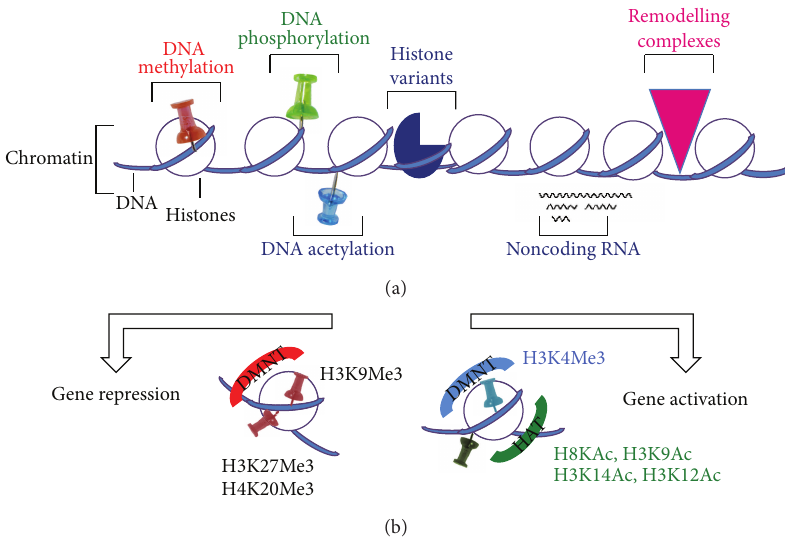
Figure 1: Scheme of histone and epigenetic modifications. (a) Chromatin structure can be modified in 5 different ways: DNA methylation, histone modification, remodeling by chromatin-remodeling complexes, insertion of histone variants, and the effects of noncoding RNAs (ncRNAs). (b) Histone modifications such as H3 lysine-9 methylation (H3K9me) or H3 lysine-27 methylation (H3K27me) result generally in gene repression, whereas H3 lysine-9/14 acetylation (H3KAc) and H3 lysine-4 methylation (H3K4me) are generally activation